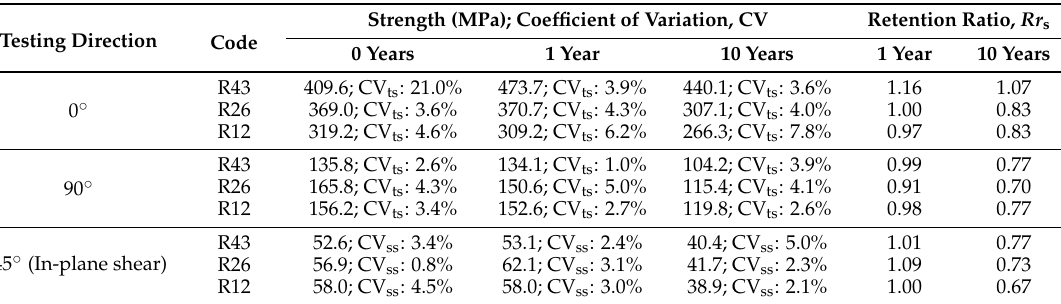
Table 4. Tensile and in-plane shear strengths of unpainted specimens with retention